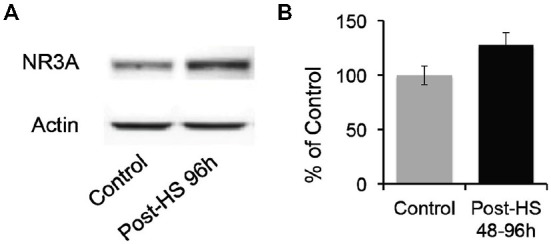
Hypoxic seizures slightly increase GluN3A subunit expression in hippocampal CA1 neurons. (A) Representative Western blot of GluN3A subunit in micro-dissected hippocampus CA1 from control and 96 h post-HS rats. (B) Western blot quantification of total GluN3A subunit expression in micro-dissected hippocampus CA1 from control and 48–96 h post-HS rats (n = 10, 10, p = 0.075). Error bars indicate S.E.M.